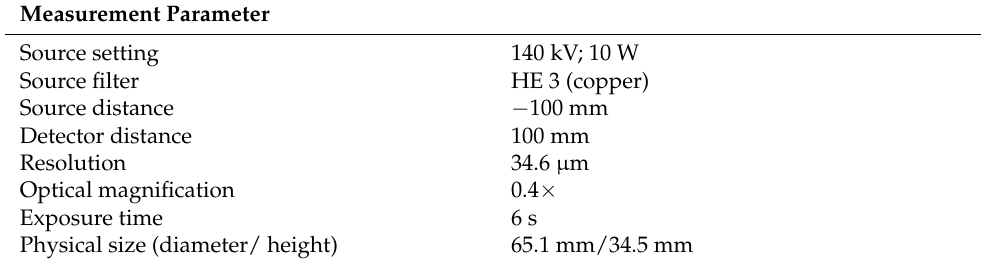
Figure 7. High-resolution computed tomography; type: Xradia 520 Versa [22]. Table 3. Measurement parameters.